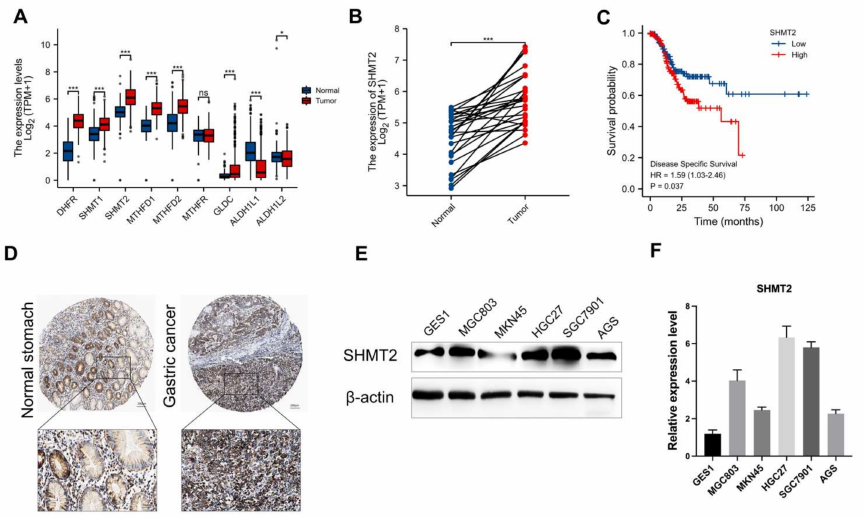
Figure 1. Serine hydroxymethyltransferase 2 (SHMT2) was highly expressed in patients with gastric cancer (GC) and was associated with a poor prognosis. ( A ) Differential expression of genes related to one-carbon metabolism in GC patients based on The Cancer Genome Atlas (TCGA)-GC samples. ( B ) The relative mRNA levels of SHMT2 in 27 pairs of normal gastric and tumor tissues from TCGA- GC samples. ( C ) Prognostic analysis of disease-specific survival in GC patients stratified by SHMT2 expression levels using Kaplan–Meier plots. ( D ) Representative IHC staining of SHMT2 in normal gastric and tumor tissues from GC patients from the Human Protein Atlas. Scale bar, 200 µ m and 50 µ m. ( E ) Expression of SHMT2 protein level in normal gastric cells and GC cells. ( F ) Expression of SHMT2 mRNA level in normal gastric cells and gastric cancer cells. * p < 0.05, *** p < 0.001;